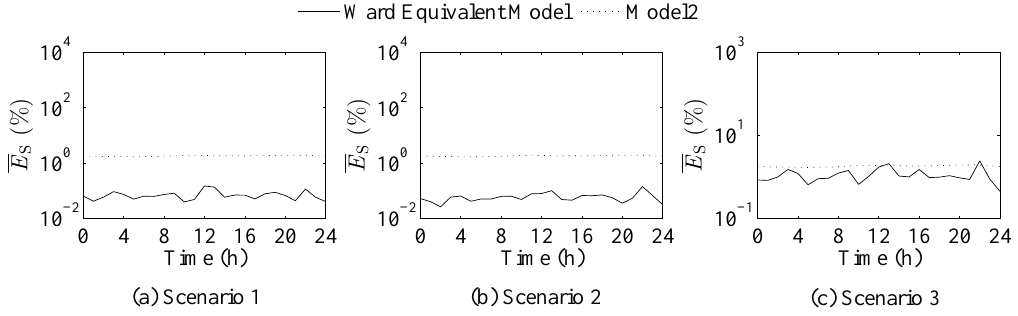
Figure 14. Mean complex power errors produced by the two models in the different scenarios.